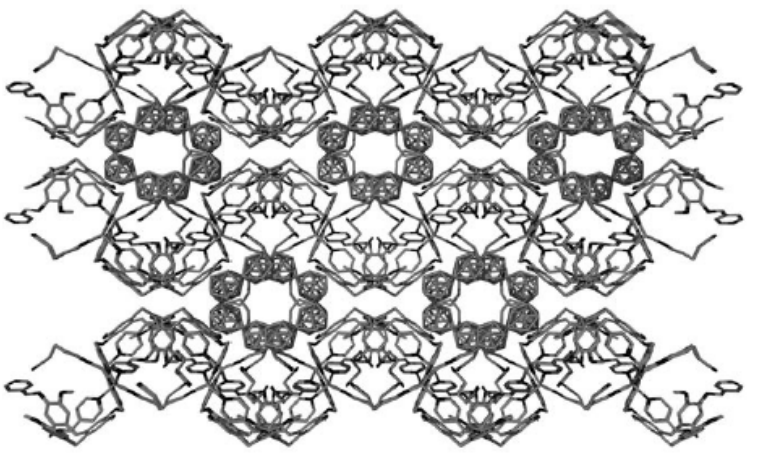
Figure 118. The crystal packing in {[Ag(tris(4-pyamino)CTG){NC(CH 2 ) 3 CN}] ∩ (NC(CH 2 ) 3 CN) The crystal packing in {[Ag(tris(4-pyamino)CTG){NC(CH 2 ) 3 CN}] X (NC(CH 2 ) 3 CN) [3,3’-Co(1,2-C 2 B 9 H 11 ) 2 ]·n(NC(CH 2 ) 3 CN)} n . Reproduced with permission from reference [108]. [3,3 1 -Co(1,2-C 2 B 9 H 11 ) 2 ] ¨ n(NC(CH 2 ) 3 CN)} n . Reproduced with permission from reference